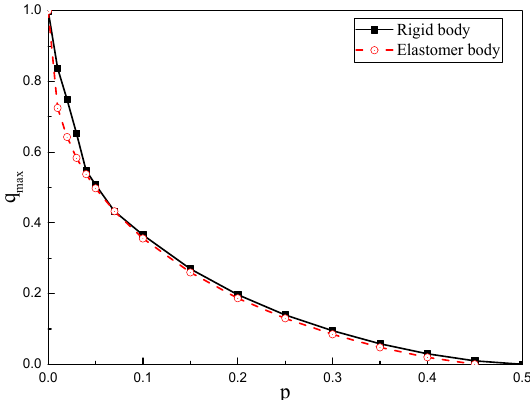
Figure 11. The relationship curves between q max and p for rigid and elastomer bodies.